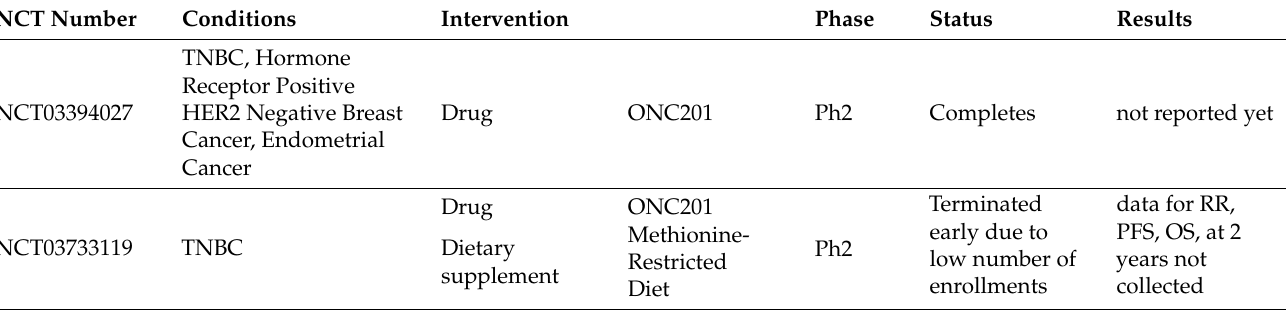
Table 4. Status of clinical trials using ClpP agonists in breast cancer